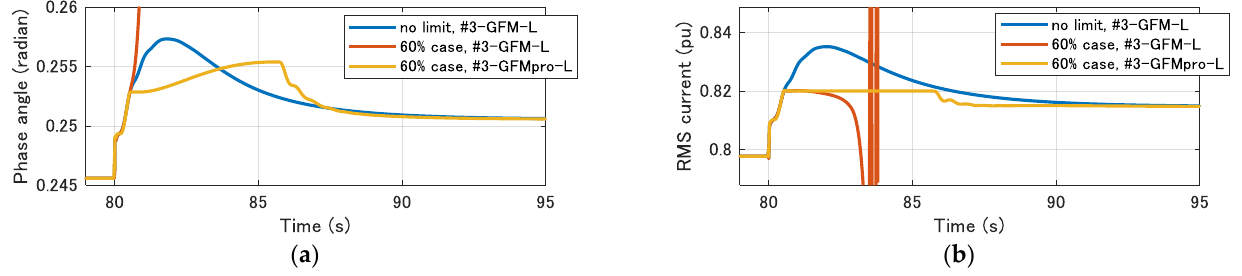
Figure 11. Response of VI-GFM with/without the proposed modification logic of phase angle of the internal voltage source. ( a ) Phase angle of the internal voltage source, ( b ) Output current of